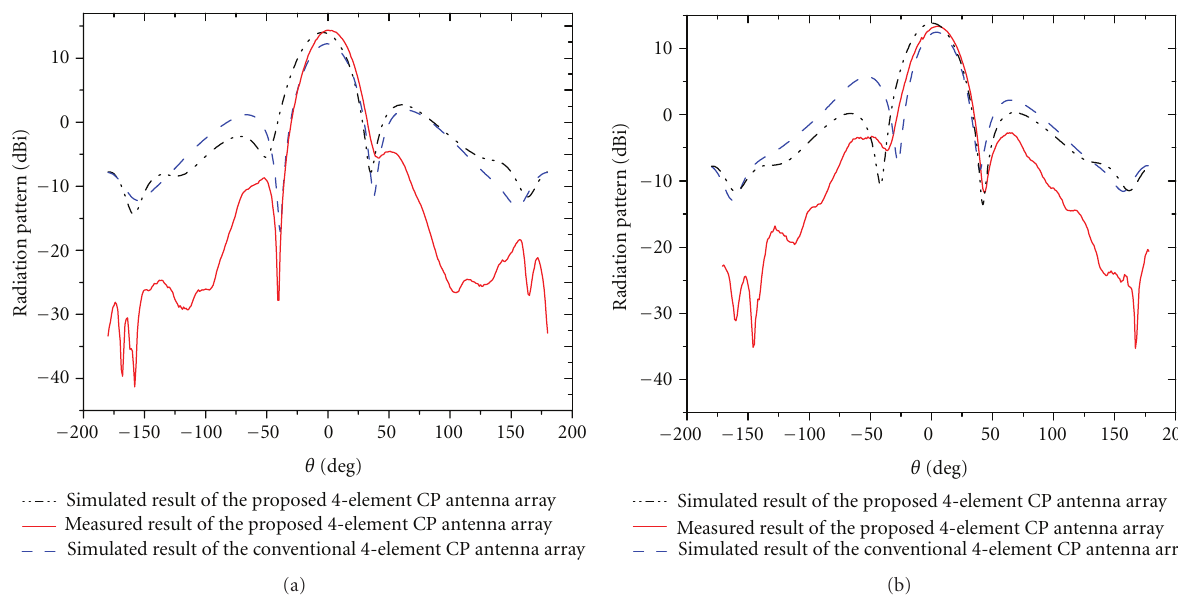
Figure 10: Measured and simulated radiation patterns of the 4-element CP antenna arrays at 29GHz: (a) ϕ = 0 ◦ , (b) ϕ = 90 ◦ .